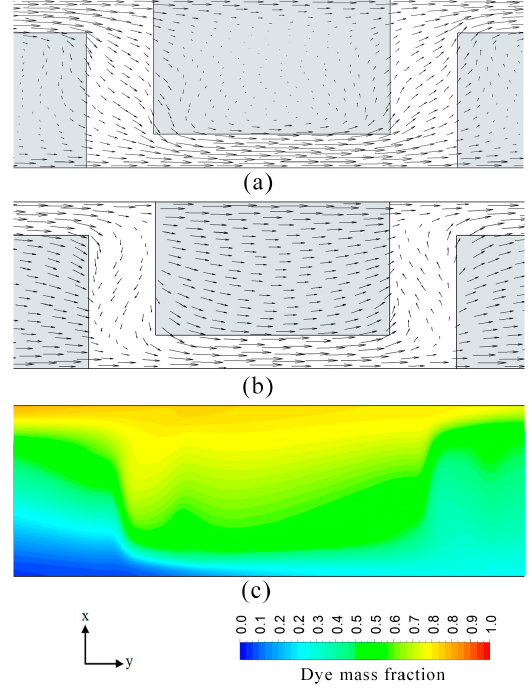
Figure 16. Flow and mixing visualization in the proposed micromixer in the x - y plane at E = 400 V/cm: ( a ) velocity vectors in x - y plane at z / H c = 0.3; ( b ) velocity vectors at z / H c = 0.6; and ( c ) Dye mass fraction distribution in x - y y - x at z / H c = 0.5.